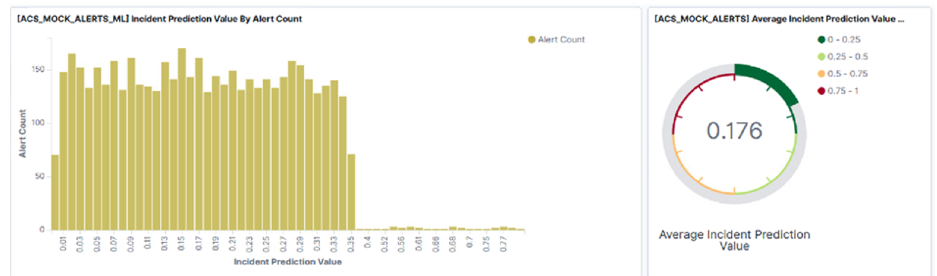
Figure 11. Alerts Dashboard—Incident prediction probability visualizations.